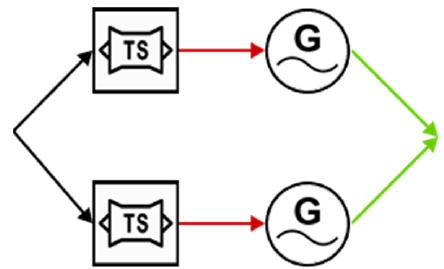
Figure 9. Combined system with non-constant efficiency and power.